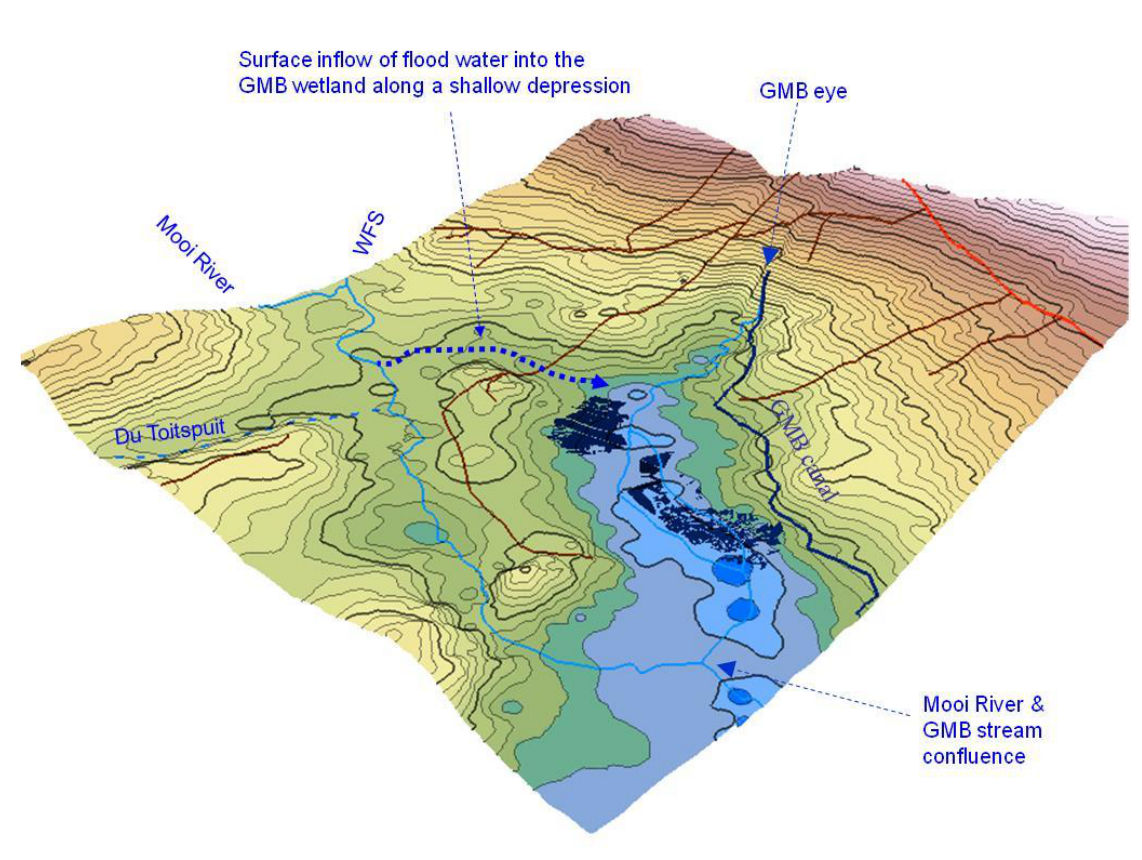
Figure 2. Digital elevation model of the study area indicating a shallow depression in topography via which flood water from the Upper Mooi River and the Du Toit Spruit sporadically flows into the Gerhard Minnebron (GMB) wetland (GIS: